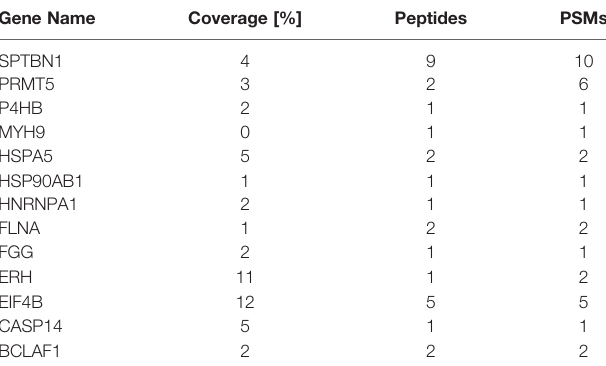
TABLE 6 | MS analysis of SMPDL3A-associated